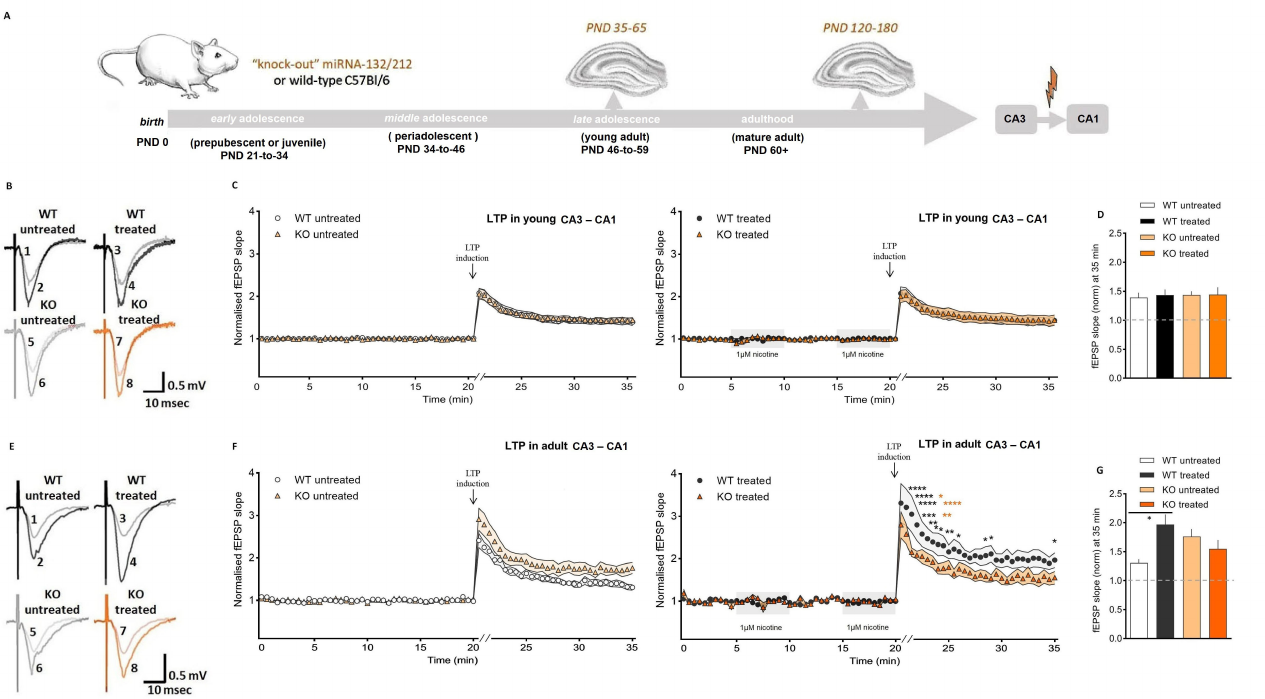
Figure 4. Nicotine enhances LTP at CA3–CA1 synapses of adult but not adolescent wild-type mice. ( A ) Schematic study design and experimental approach to study LTP induction at the Schaffer collateral output synapses. ( B ) Demonstrative fEPSPs during base line recordings (indicated with numbers 1, 3, 5, and 7) and after inducing LTP (indicated with numbers 2, 4, 6, and 8), as